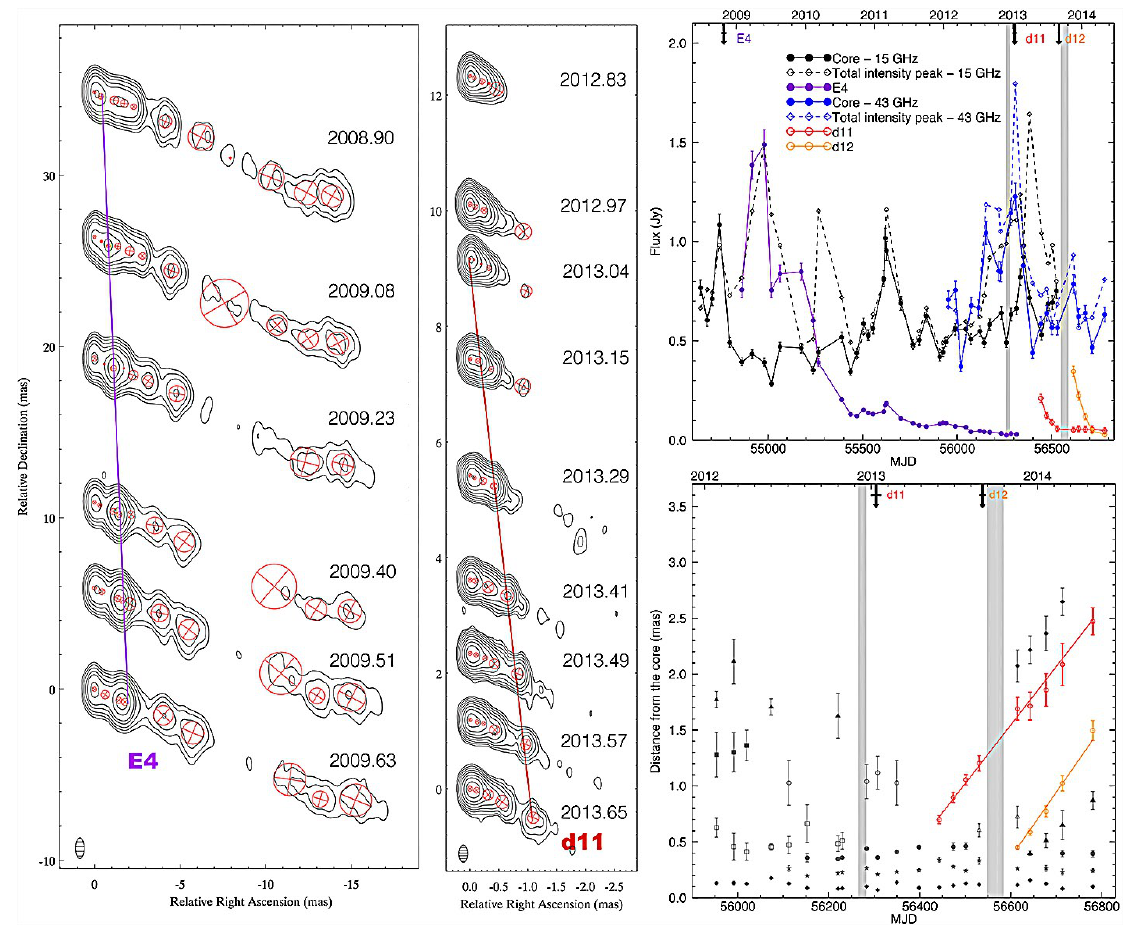
Figure 1. Left and center: Sequence of total intensity 15 GHz ( left ) and 43 GHz ( center ) VLBA images of 3C 120. The images show the appearance of components E4 and d11. Contours are traced at 0.0015, 0.004, 0.009, 0.02, 0.05, 0.10, 0.30, 0.60, 1.20 Jy/beam, in the 15 GHz sequence, and at 0.003, 0.006, 0.014, 0.03, 0.07, 0.15, 0.34, 0.74, 1.64 Jy/beam, in the 43 GHz image. Red circles represent model-fits components; Right: 15 GHz and 43 GHz light curves of the total intensity peaks and main model-fit components ( top ) and distance from the core vs. time ( bottom ) for the 43 GHz model-fit components. Grey shaded areas correspond to the γ -ray